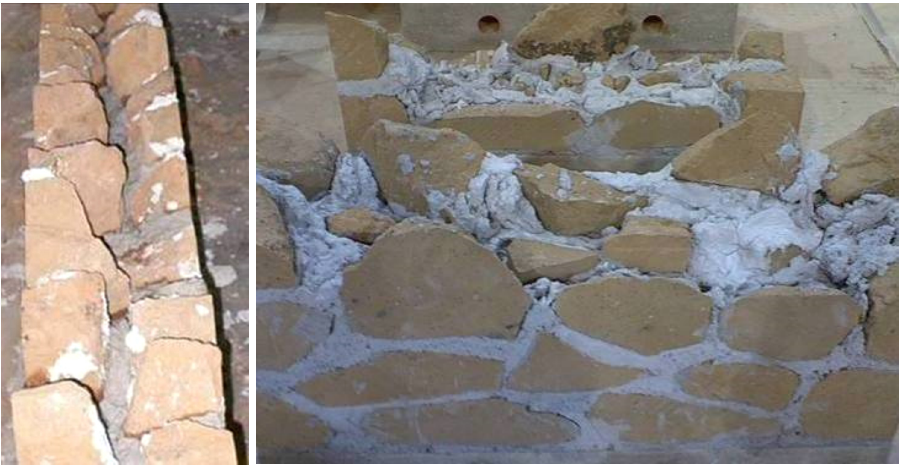
Figure 3. Masonry texture and section of the walls of the